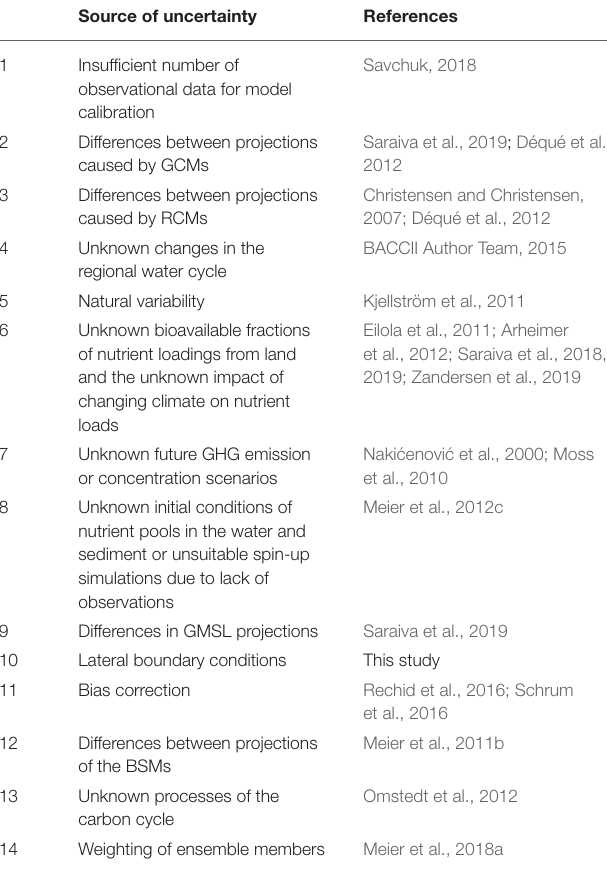
TABLE 2 | Sources of uncertainty addressed by this study and selected key references of the Baltic Sea. For details, the reader is referred to the